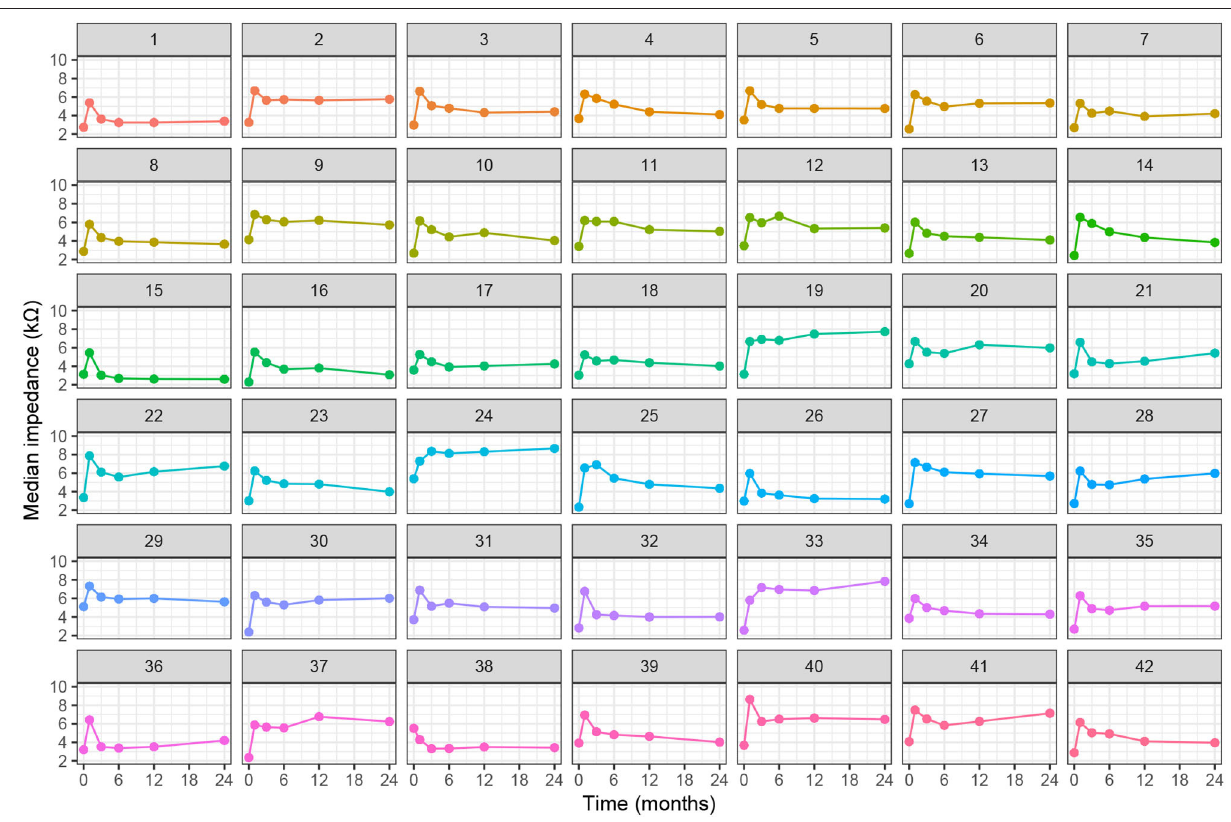
Frontiers in Neurology |